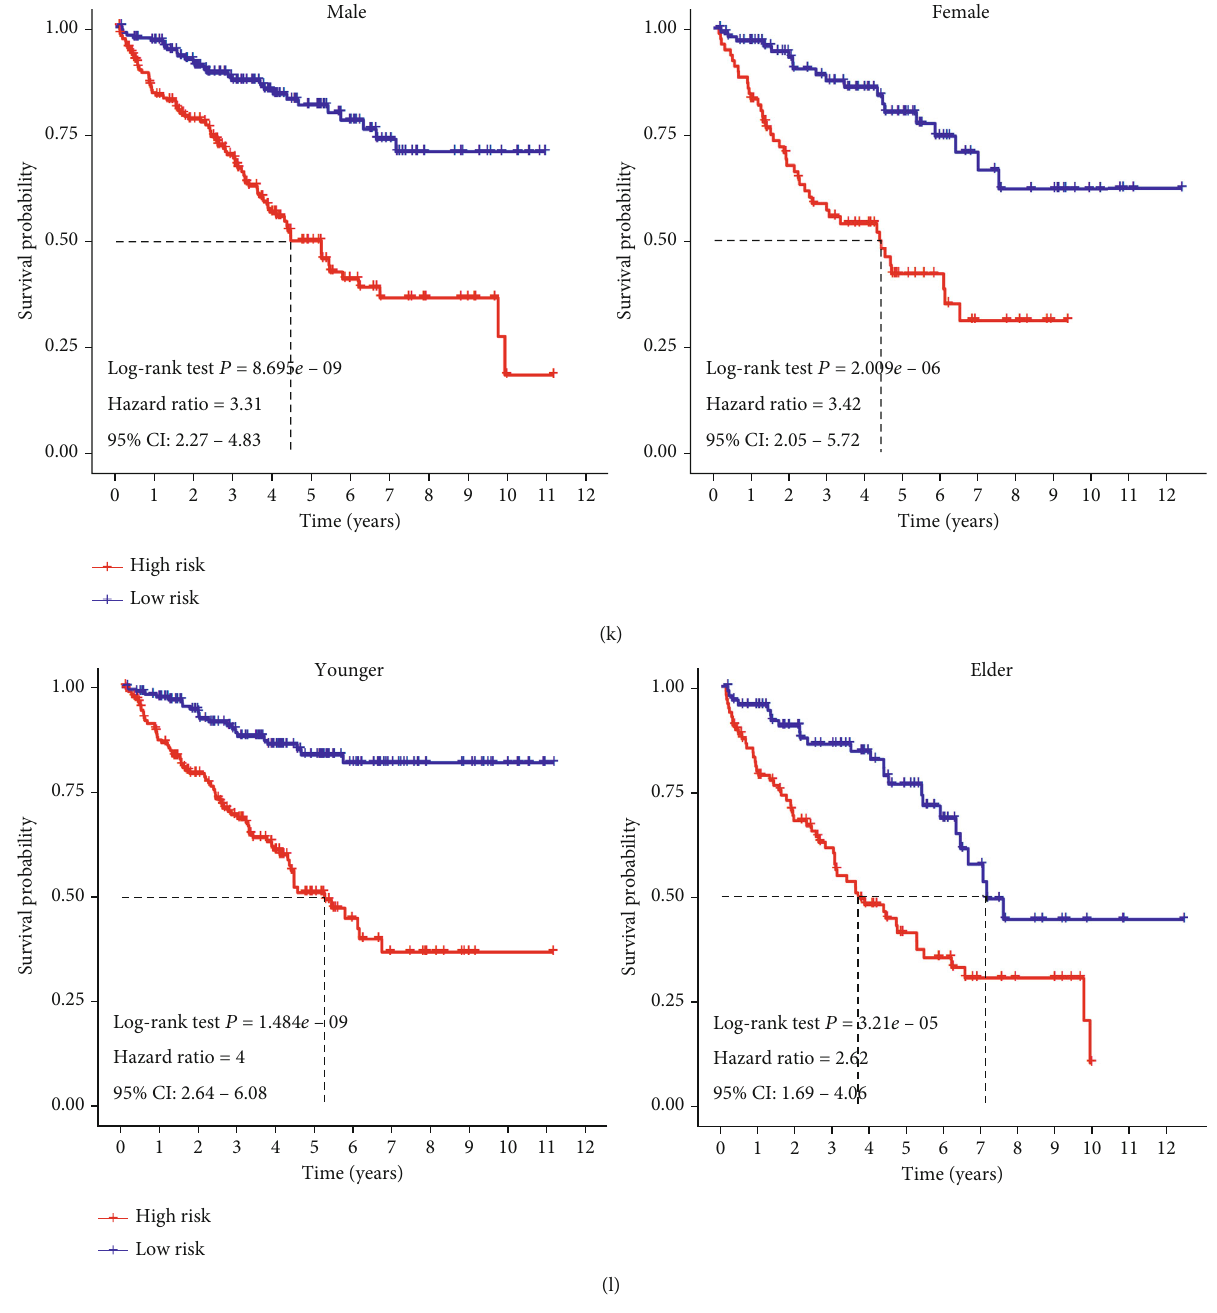
Figure 5: Principal component analysis of three sets and Kaplan-Meier survival analysis of the fi ve-lncRNA signature in di ff erent subgroups of clinical parameters. (a – c) Principal component analysis of the training set, the testing set, and the whole set based on the 5-lncRNA expression. (d – f) Principal component analysis of the training set, the testing set, and the whole set based on the whole immune-related lncRNA expression. The red dots represent the high-risk patients, while the blue dots represent the low-risk patients. (g – l) Survival analysis of the fi ve-lncRNA signature in stages I and II, stages III and IV, grades 1 and 2, grades 3 and 4, metastasis, without metastasis, pharmaceutical, without pharmaceutical, male, female, elder, and